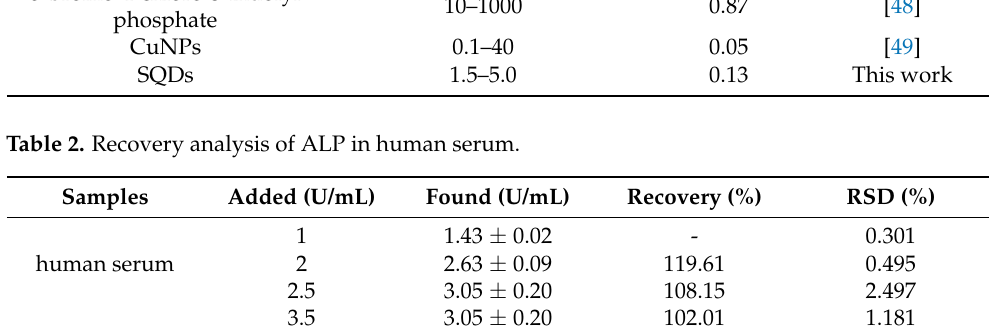
Table 2. Recovery analysis of ALP in human serum.